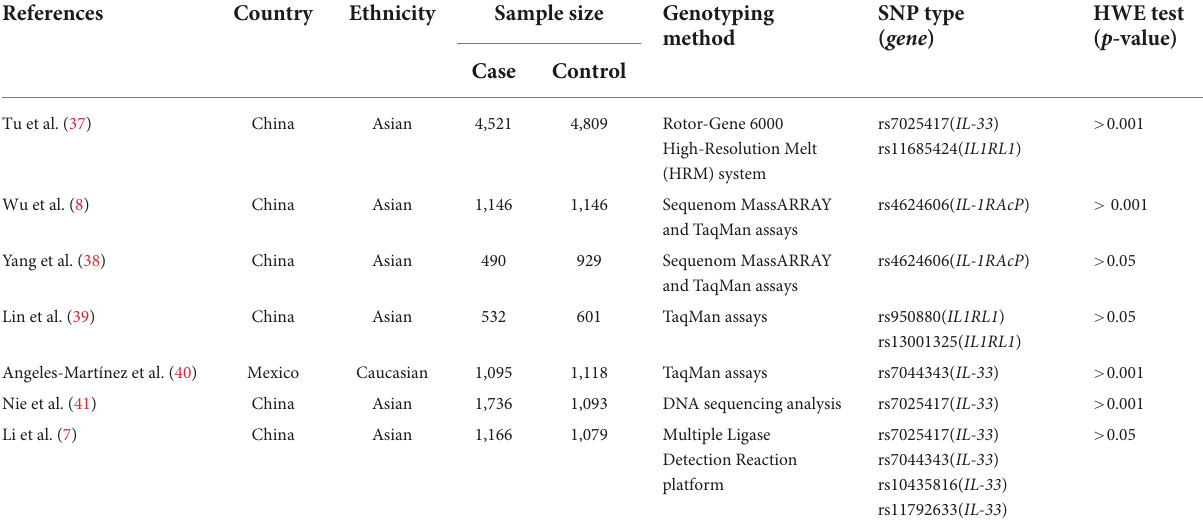
TABLE 1 Characteristics of the studies included.